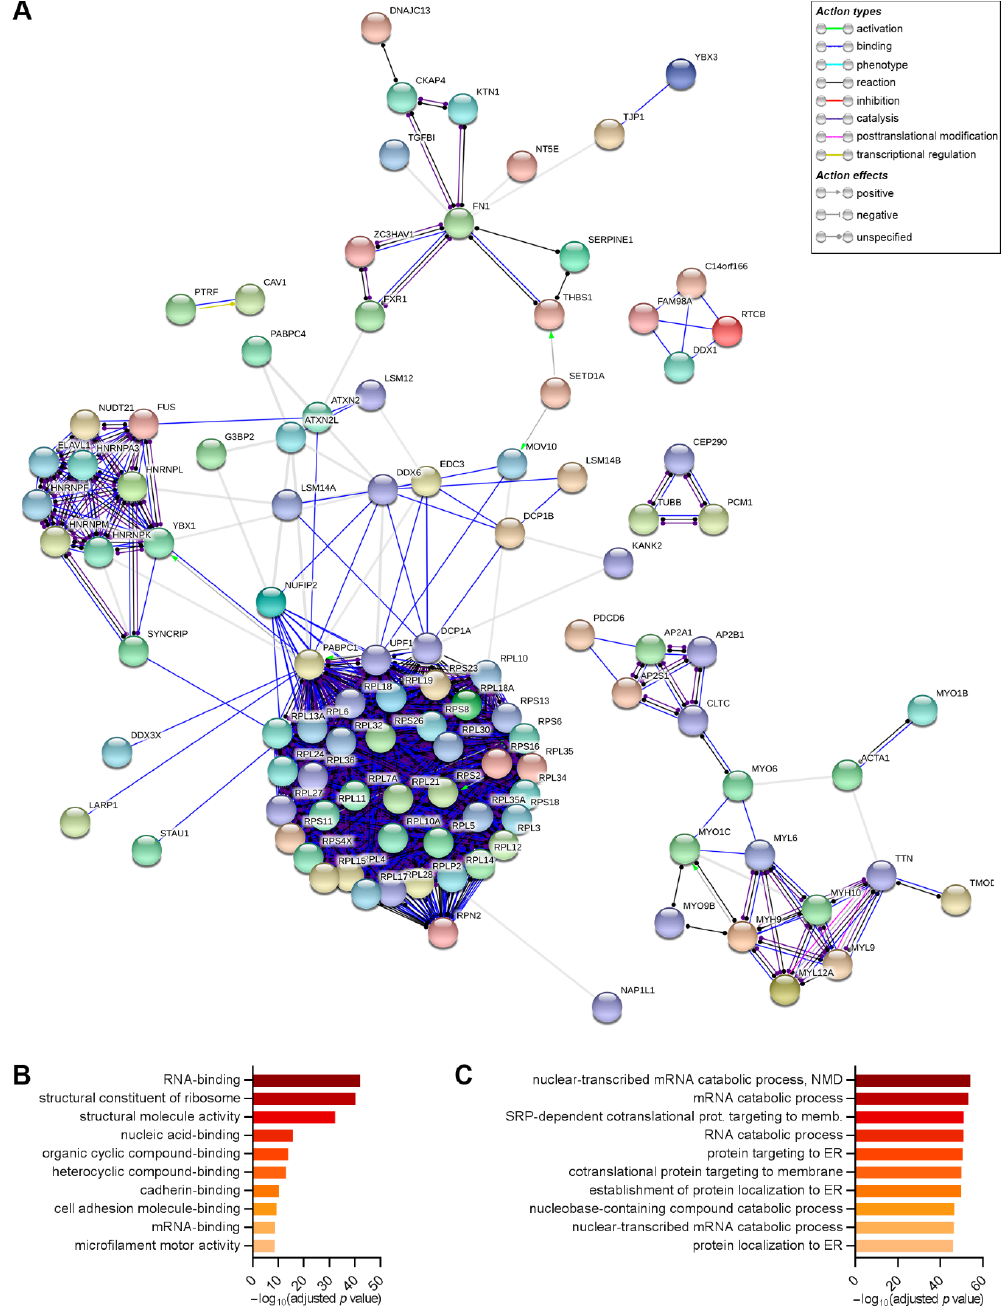
Figure 6. Interaction mapping and gene ontology of the proteins identified by coimmunoprecipitation with DDX6 in the hASCs that were not induced or induced to adipogenesis or osteogenesis for 24 h. ( A ) The interactions among the proteins identified by coimmunoprecipitation with DDX6 were analyzed using the STRING database. The map (produced using STRING, version 11.0) shows the proteins with predicted interactions of high confidence (STRING score > 0.7). ( B ) Enriched terms found by gene ontology analysis in the molecular function category (gProfiler). The bar graph represents the 10 terms with the lowest adjusted p value. ( C ) Enriched terms found by gene ontology analysis in the biological processes category (gProfiler). The bar graph represents the 10 terms with the lowest adjusted p value. ER = endoplasmic reticulum and NMD = nonsense-mediated decay.